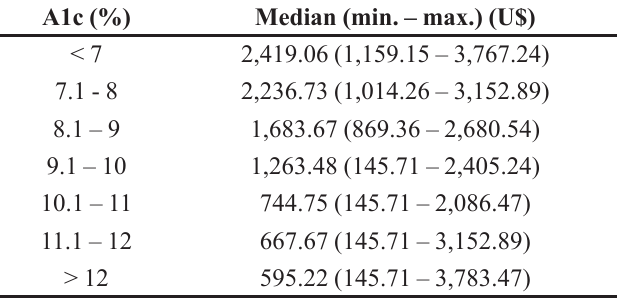
TABLE I - Annual investment of the health service management according to glycemic control of the patient with diabetes mellitus type 2 (DM2), after consensus of specialists. Source: